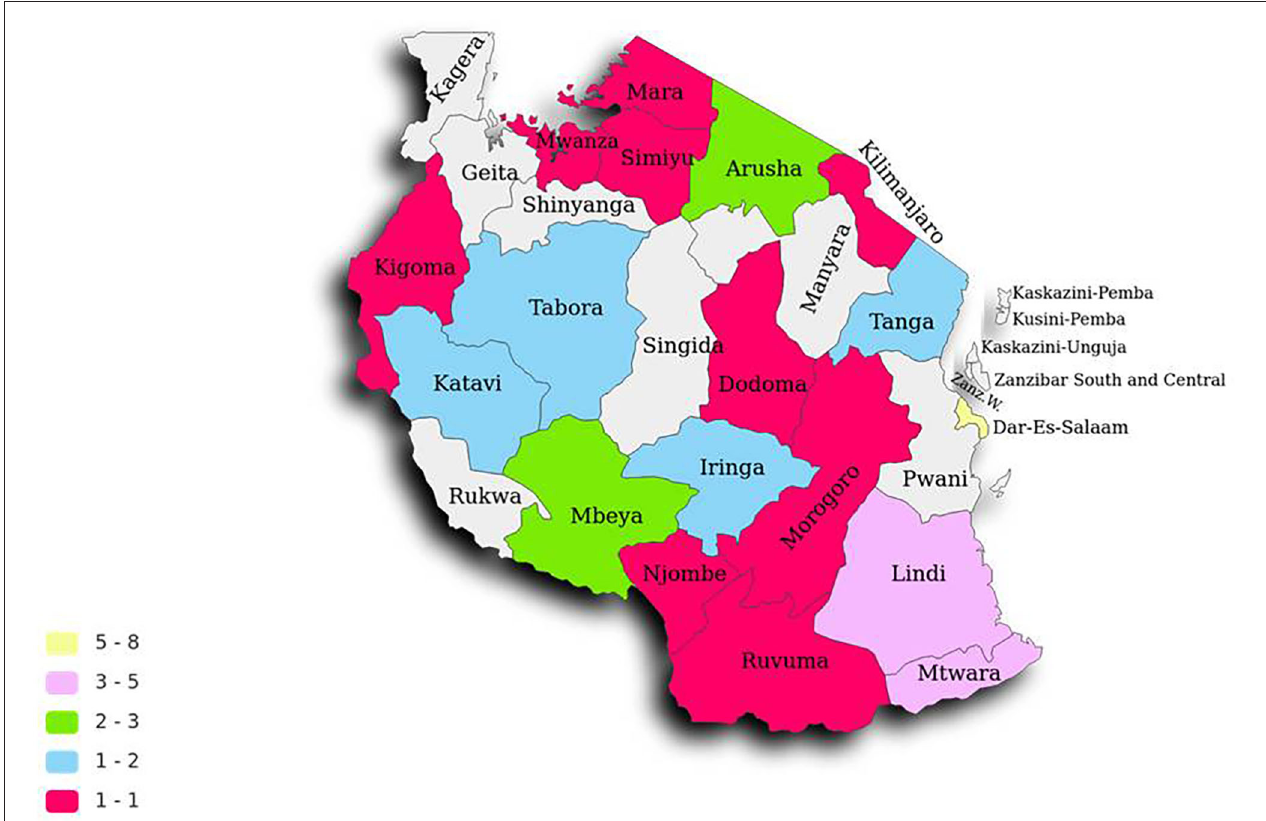
FIGURE 1 | Geopolitical distribution of respondents in Tanzania mainland regions’